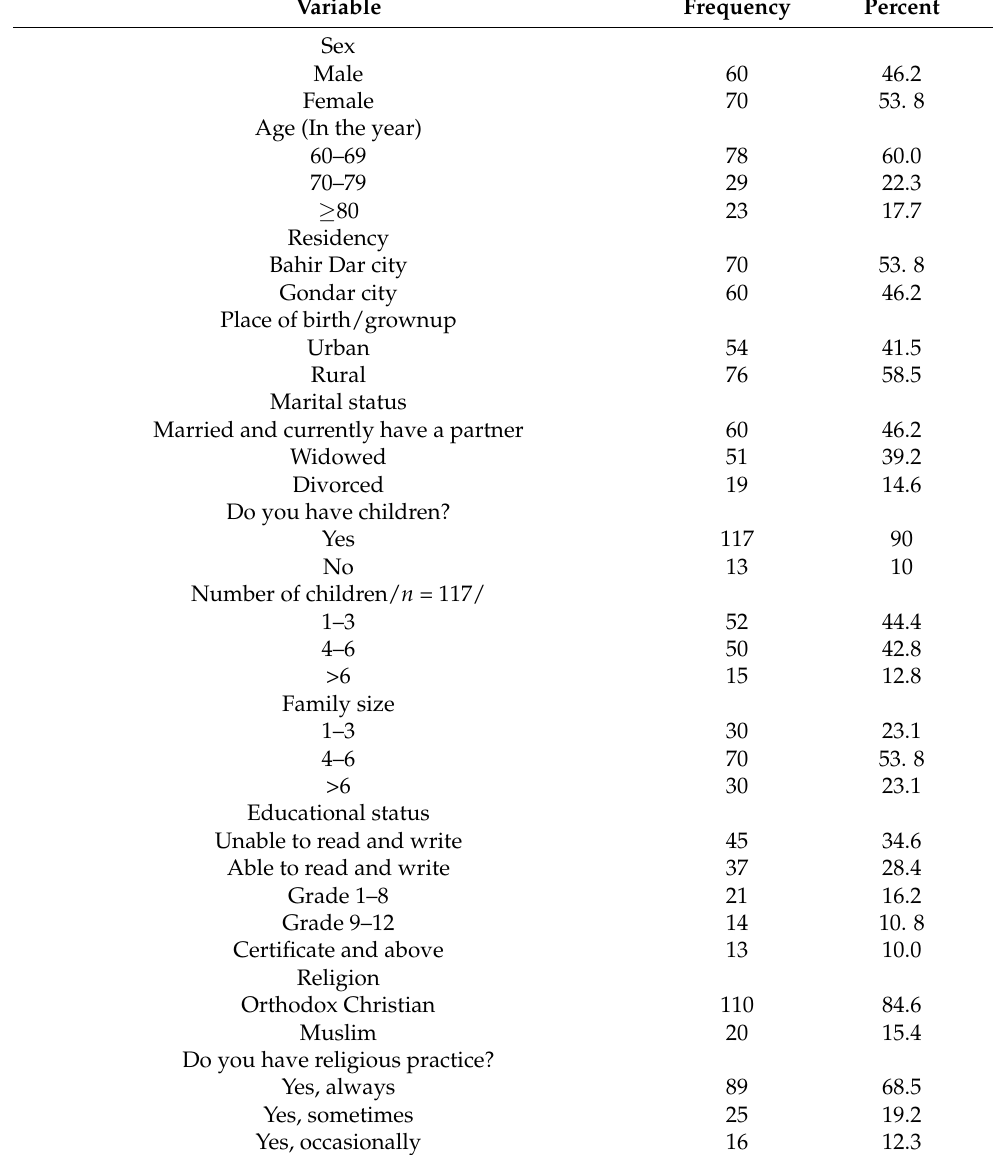
Table 1. Sociodemographic characteristics of elders living in metropolitan cities of northwest Ethiopia, 2020 ( n =